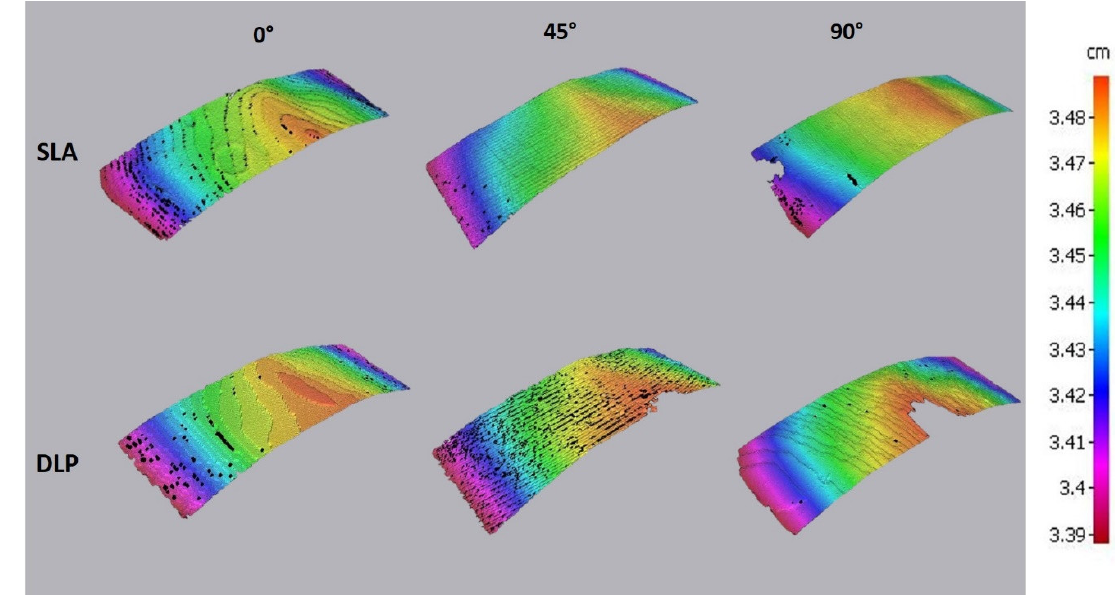
Figure 10. The optical 3D metrology showing differences in layer orientation for SLA and DLP specimens.